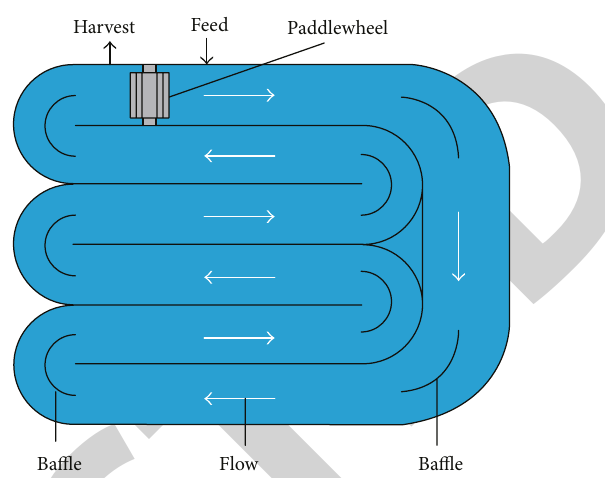
Figure 2: Raceway ponds with multiple loops and baffles